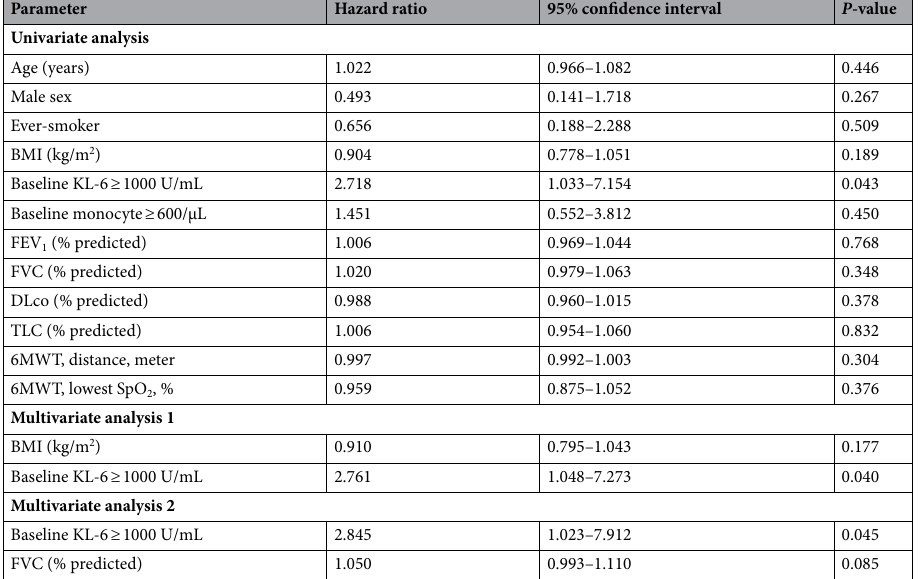
Table 3. Risk factors for disease progression in patients with IPF by Cox proportional hazards model. IPF: Idiopathic pulmonary fibrosis, BMI: Body mass index, KL-6: Krebs von den Lungen-6, FEV 1 : Forced